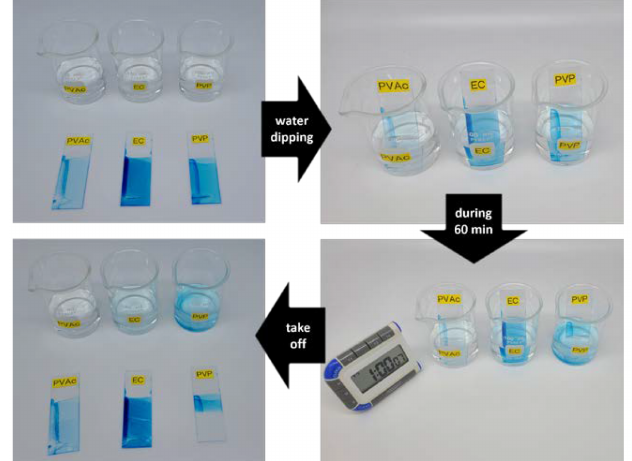
Figure 2. Photograph of dyed tooth whitening samples dipped in water during 60